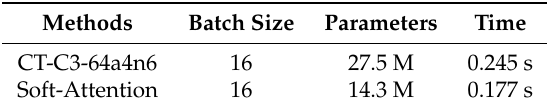
Table 5. Comparison of training time per batch for our CT model and the Soft-Attention model. The timings are obtained on single Nvidia Titan X Graphics Processing Unit